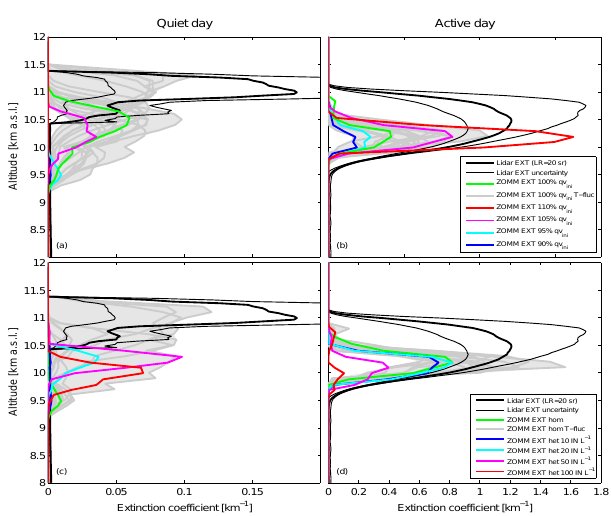
Figure A4. Extinction profiles above Jungfraujoch at 09:00UTC on 22 November 2011 (quiet day) as well as 03:00UTC on 12 March 2012 (active day) calculated from ZOMM simulations along tra- jectories with a temporal resolution of 1min. ( a , b ) Sensitivity to the initial humidity. ( c , d ) Sensitivity to the nucleation mode as- suming 95 (quiet day) and 105% (active) of the initial humidity derived from the COSMO-Model, respectively. Grey curves: simu- lations with superimposed small-scale temperature